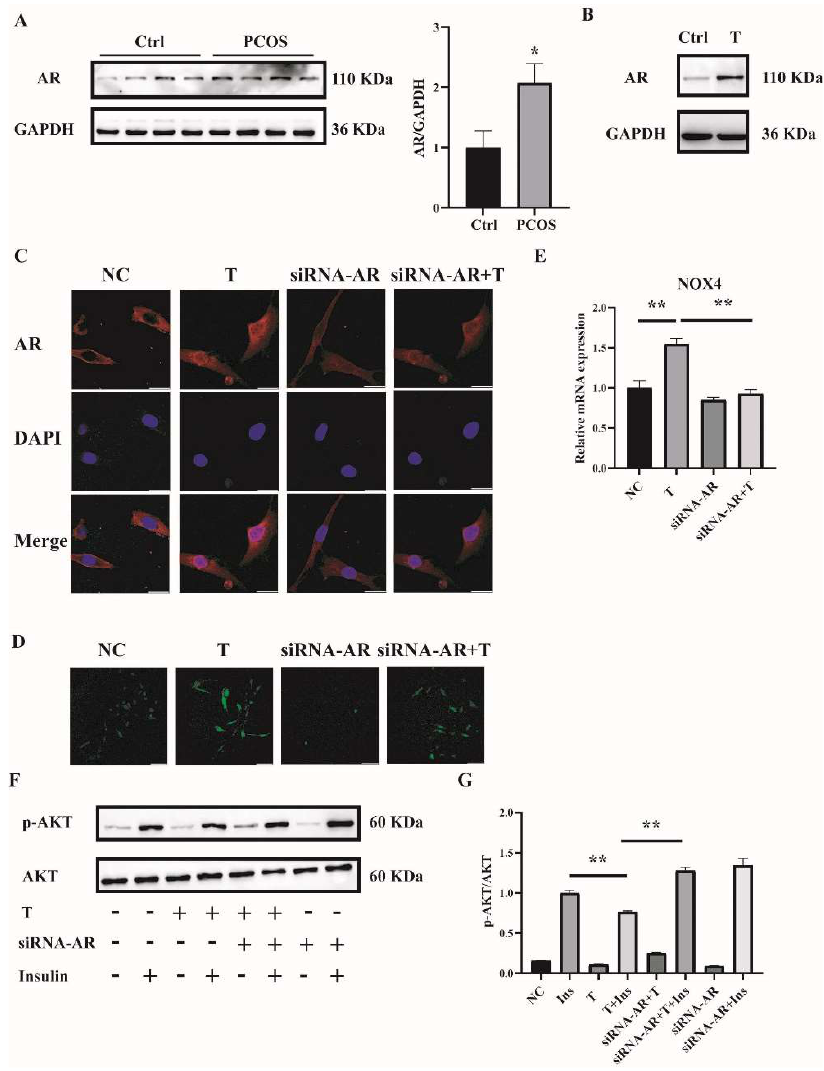
Figure 6. AR expression in the skeletal muscle of mice with PCOS and the effects of AR deficiency on the cellular oxidative stress in T-treated C2C12 cells. ( A ) Representative Western blots and densitometry quantification of AR in skeletal muscle of PCOS and control mice. ( B ) Representative Western blots of AR expression of T-treated C2C12 cells. Fully differentiated C2C12 cells were treated with T (0, 10 μM) for 12 h. AR expression was measured by Western blot analysis. ( C ) Representative photomicrographs of the subcellular localization of AR in C2C12 cells. Fully differentiated C2C12 cells were transfected with siRNA-AR or nonsilencing RNA (NC) and then treated with T (0, 10 μM) for 12 h. Red: AR; Blue: DAPI. Scale bar = 25 μm. ( D ) Representative photomicrographs of intracellular ROS in C2C12 cells. Fully differentiated C2C12 cells were transfected with AR siRNA or non-silencing RNA and then treated with T (0, 10 μM) for 12 h. Intracellular ROS levels were determined by DCFH-DA staining. Sale bar = 100 μm. ( E ) Relative mRNA levels of NOX4 in T-treated C2C12 cells transfected with siRNA-AR non-silencing RNA (NC). ( F ) Insulin-signaling assay. ( G ) Densitometry quantification of pAKT/AKT of the insulin-signaling assay in C2C12 cells. The data are presented as means ± SEM of three independent experiments. *, p < 0.05, **, p < 0.01. T, testosterone; AR, androgen receptor; Ins, insulin.